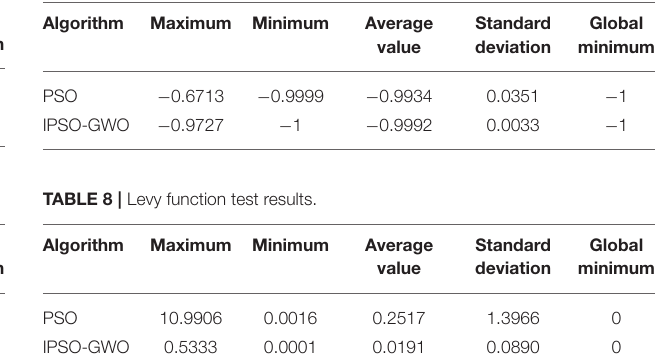
TABLE 2 | Drop Wavefunction test results.